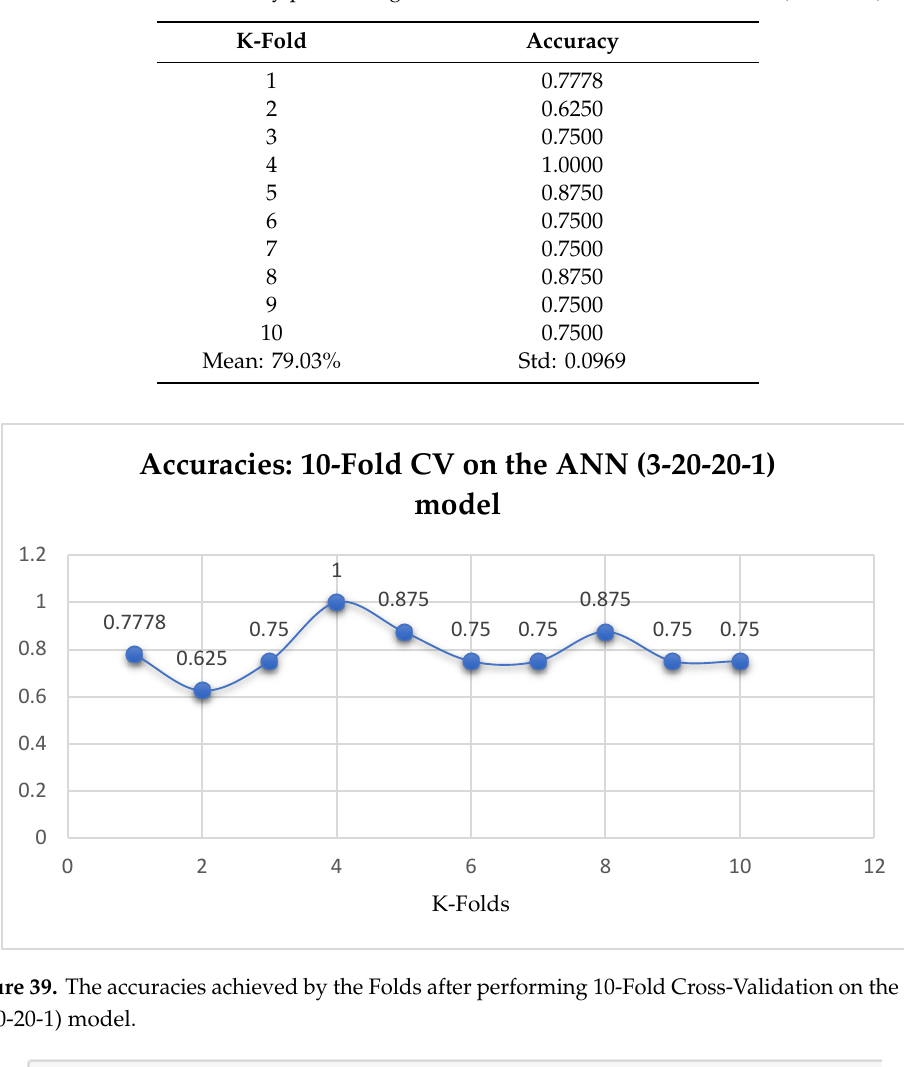
Table 14. Accuracies achieved by performing 10-Fold Cross-Validation on the ANN (3-20-20-1) model.